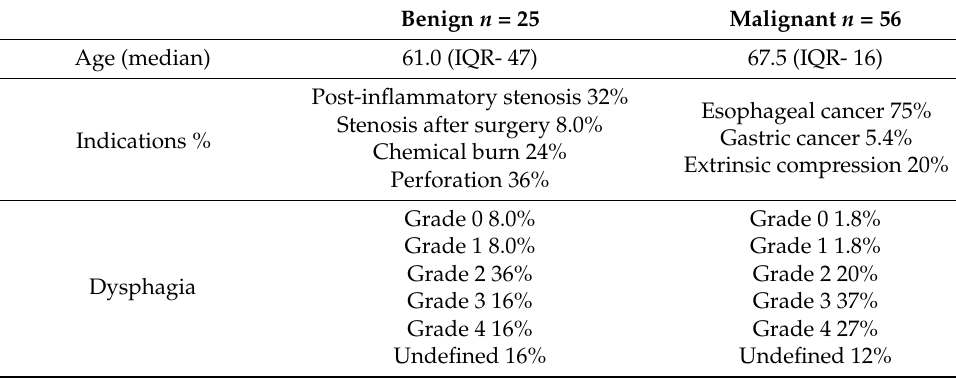
Table 1. Patients’ characteristics and indications for